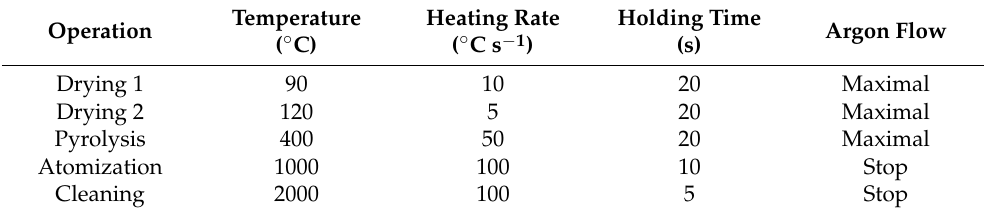
Table 1. Time-temperature program used for the coating of the graphite tube with zirconium (according to Vieira et al.